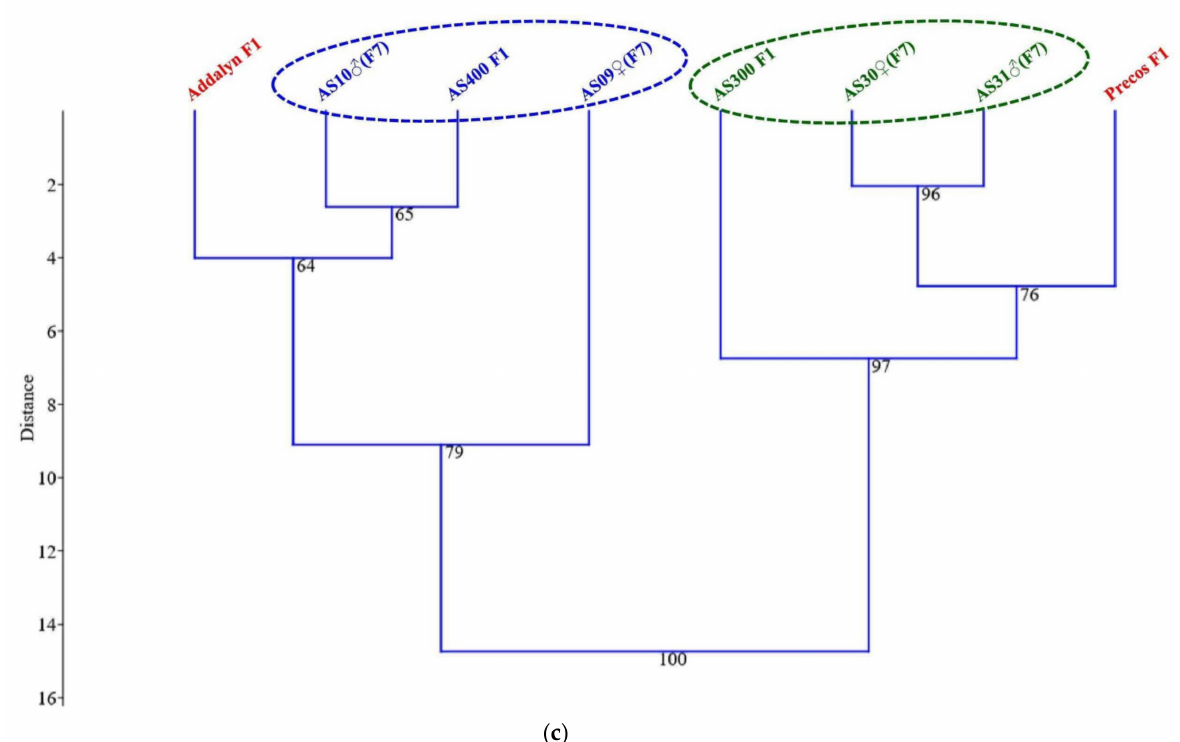
Figure 6. ( a ) Distribution of chemical components in tomato fruits based on correspondence analysis (CA); ( b ) Principal component analysis (PCA) for the two new commercial hybrids (AS 300 F1 and AS 400 F1) and their parental lines; ( c ) Hierarchical clustering—paired group UPGMA (Unweighted Pair Group Method with Arithmetic Mean)—similarity index (Euclidean) of the two new commercial hybrids and their four parental lines (F7), and the two commercial hybrids used as